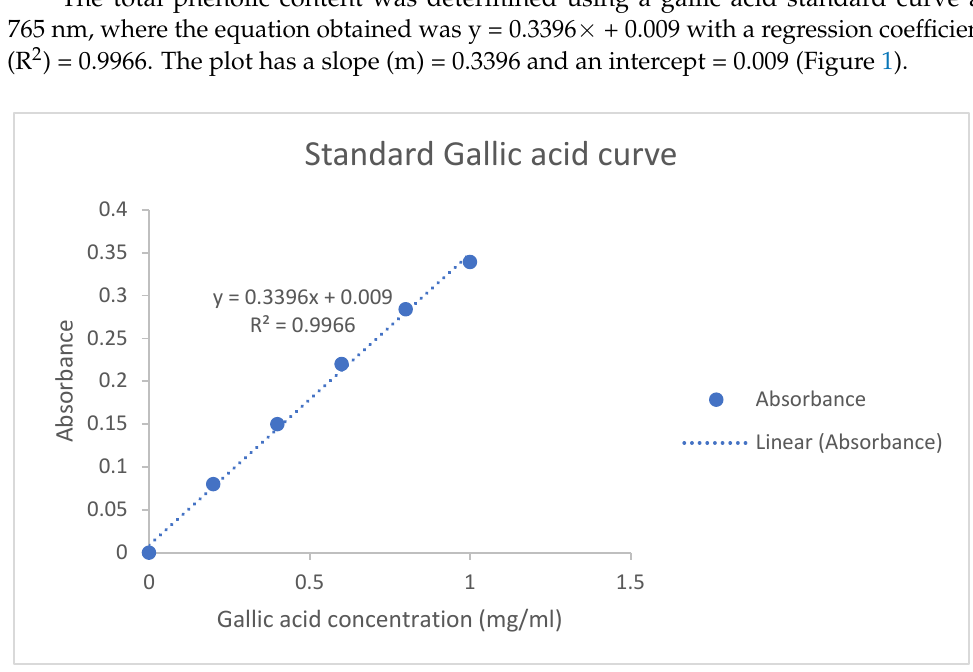
scavenging free radicals, and reduction in free radicals formation